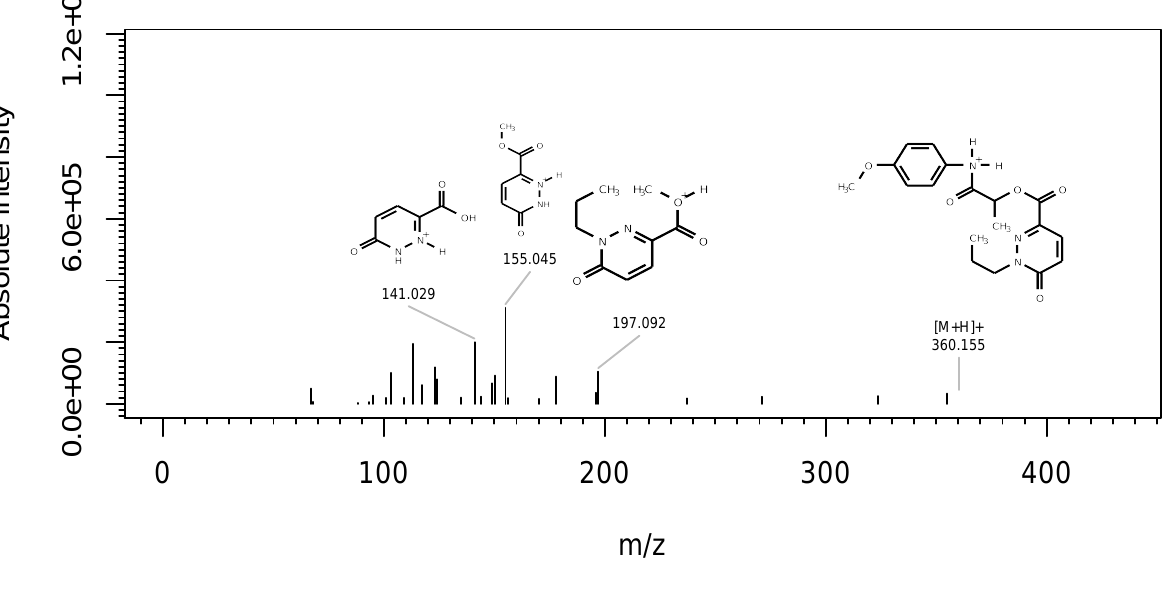
Figure A13. Challenge 16: annotated merged MS and MS/MS spectra of [1-(4-methoxyanilino)-1-oxopropan-2-yl] 6-oxo-1-propylpyridazine-3-carboxylate (APCI,